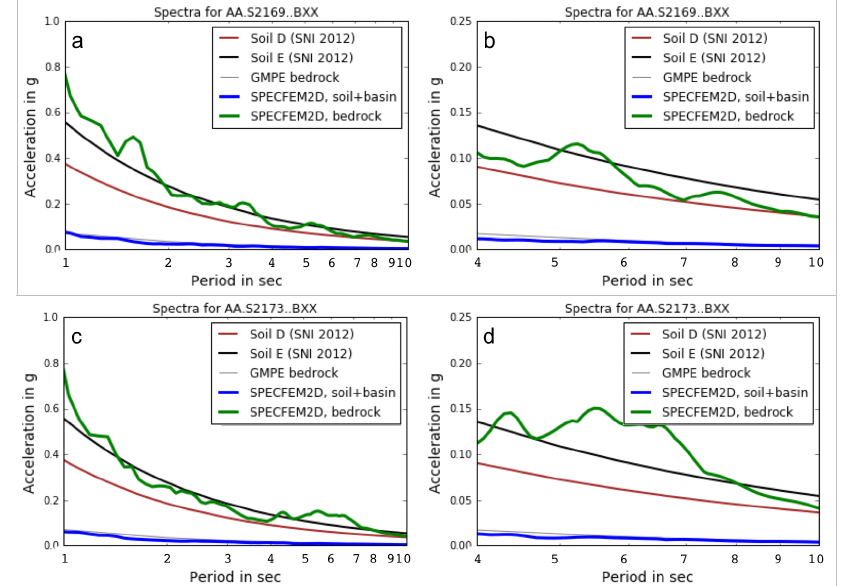
Figure 16. Computed acceleration response spectra for the megathrust earthquake scenario, plotted with the PSA using the AEA2015 GMPE and the Jakarta Building Code’s design response spectra (for D-type soil, thick-black curve) at stations ( a ) S2169 and ( c ) S2173. ( b , d ) are zoomed images of ( a , c ), respectively for the period band 4–10 s. Location of stations are indicated in Figures 14 and